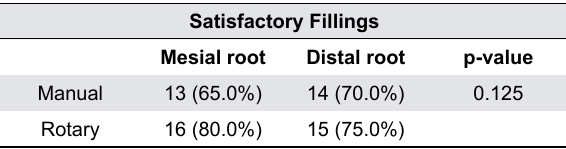
Table 3- Analysis of the quality of root canal filling, according to the instrumentation technique